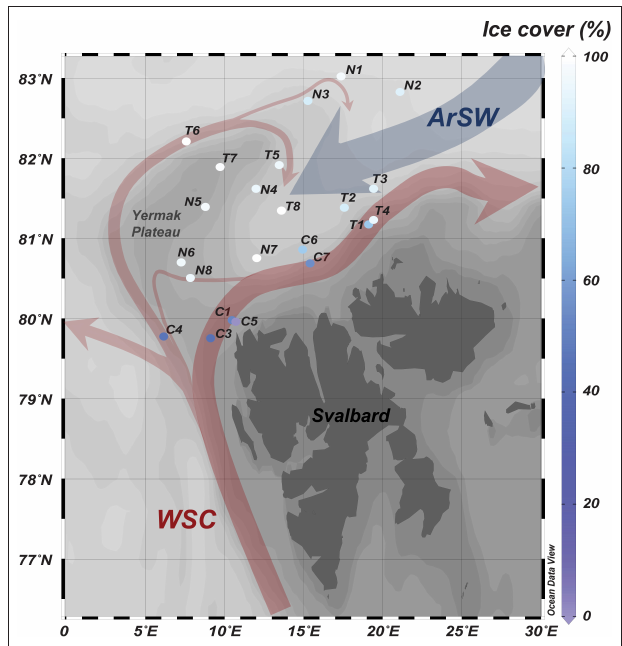
FIGURE 1 | Map of the sampling stations, with rough visualization of the pathways of inflowing Atlantic water with the West Spitsbergen Current (WSC), subsequently splitting up in the Svalbard and Yermak AW Branches, respectively, while the blue arrow depicts the overlaying Arctic surface waters (ArSW) advected in the opposite direction. Station names refer to field campaign and order of sampling, where “C” is CarbonBridge (2014), “T”